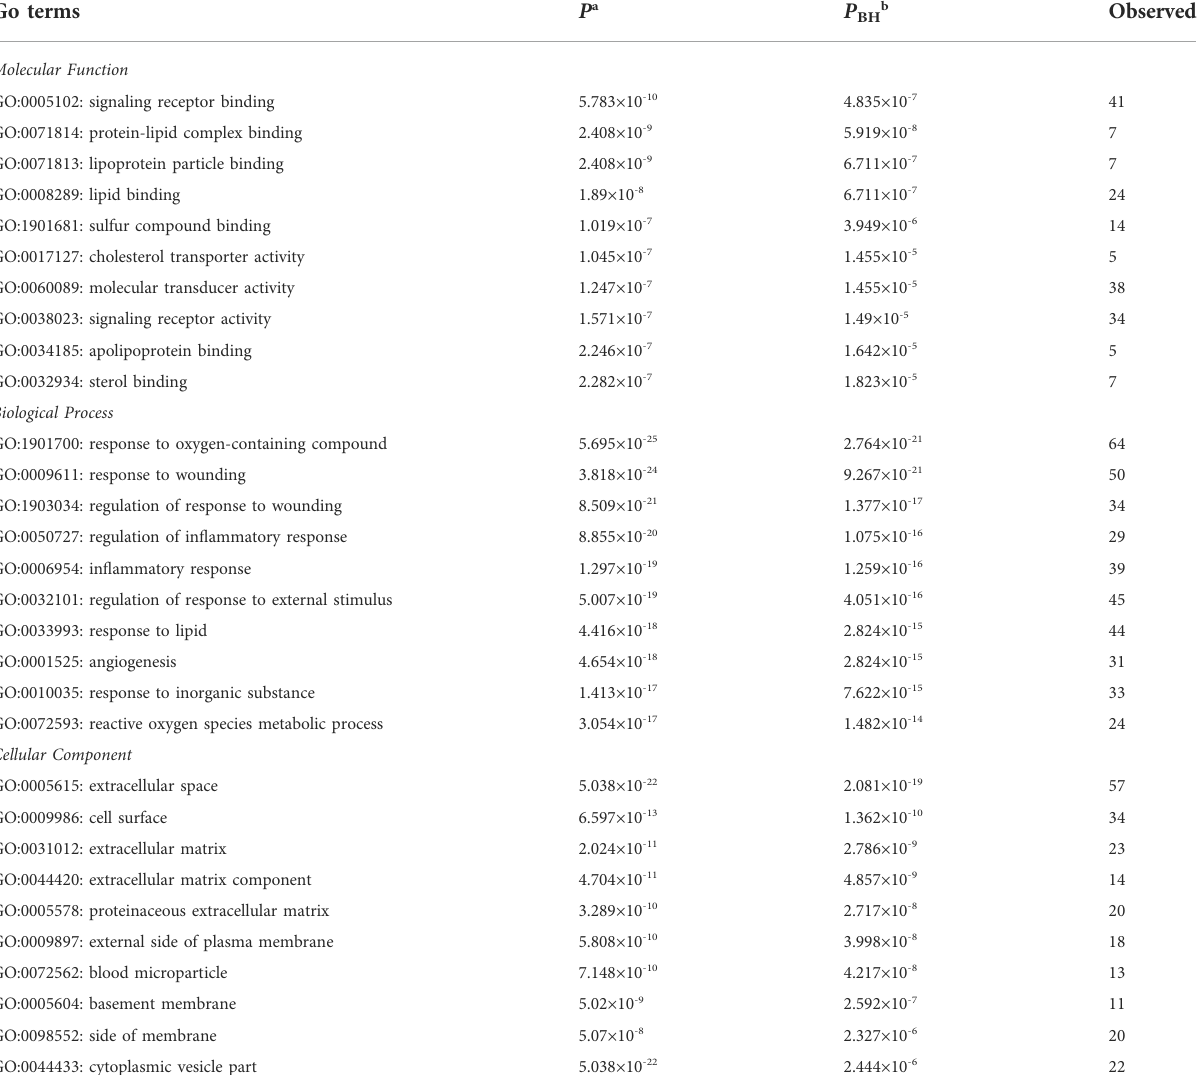
TABLE 2 Gene Ontology (GO) terms enriched with AMDgset (Top 10